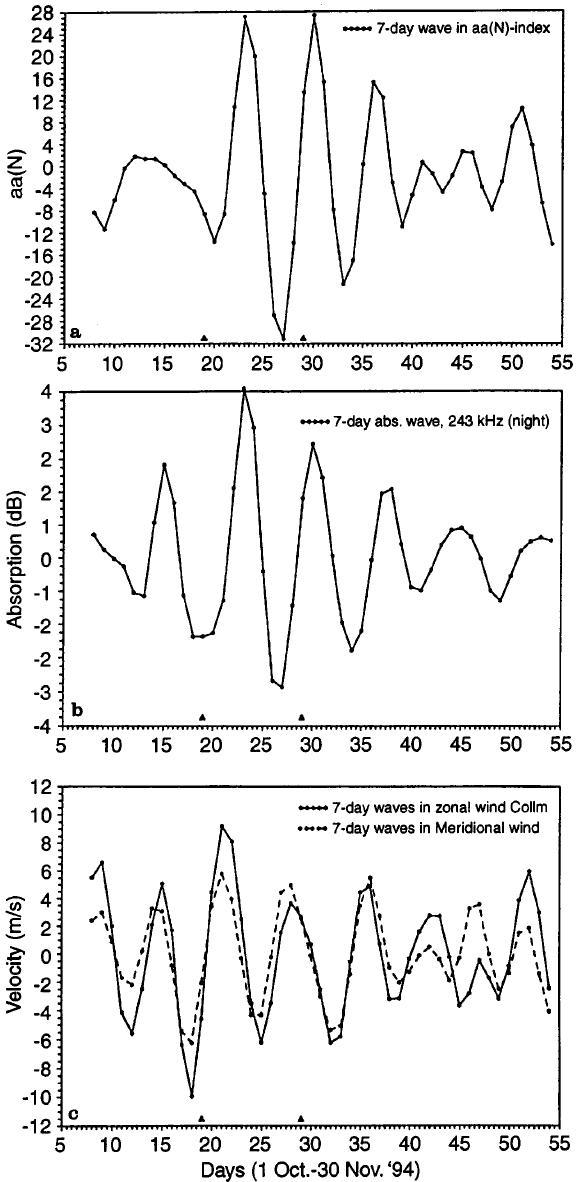
Fig. 8. About 7-day waves observed in a the geomagentic aa ( N )- index; b the night-time absorption measured at 243 kHz, and c the zonal ( solid line ) and meridional ( dashed line ) neutral wind. SSCs are marked by solid